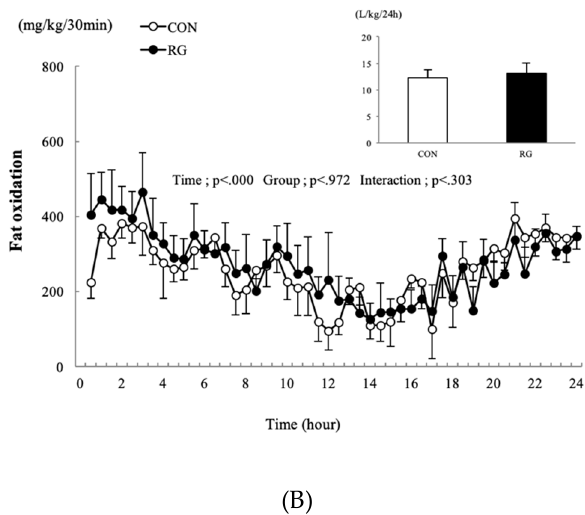
Figure 2. Changes in carbohydrate oxidation ( A ) and fat oxidation ( B ) after 2 weeks of red ginseng (RG) intake, and the sum for the control (CON) and RG groups 24 h after 2 weeks of RG intake. Values are presented as the mean ± SE.